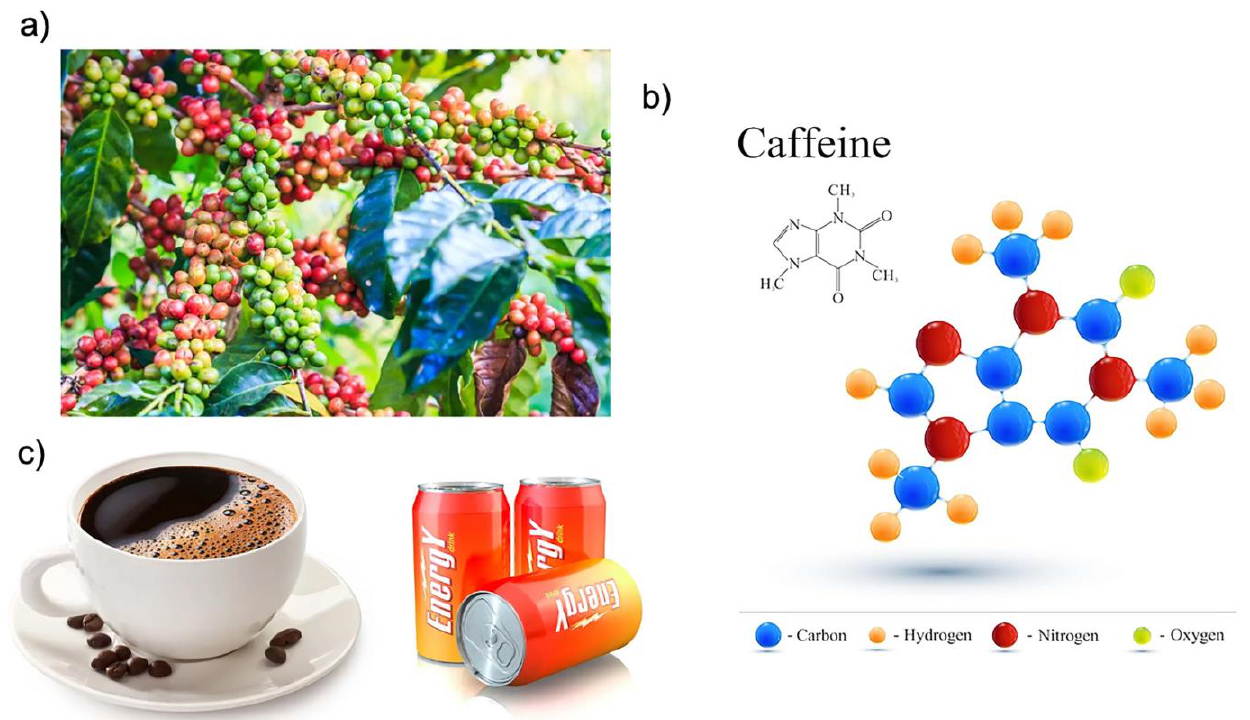
Figure 1. ( a ) Coffee beans ripening on a tree; ( b ) caffeine structure formula; ( c ) drinks containing